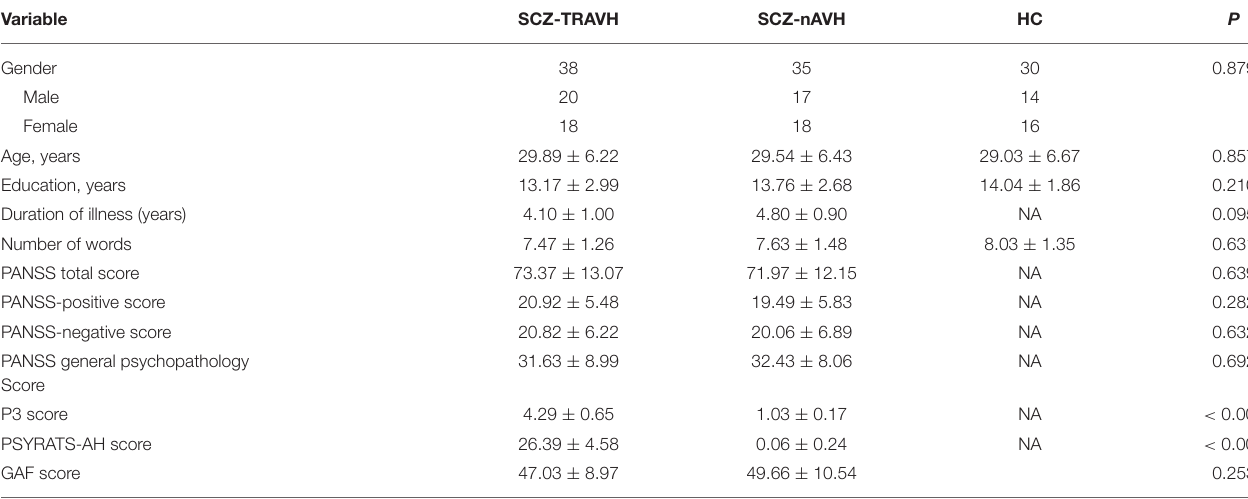
TABLE 1 | Demographic, clinical, and psychosocial characteristics of all participants ( n = 103).